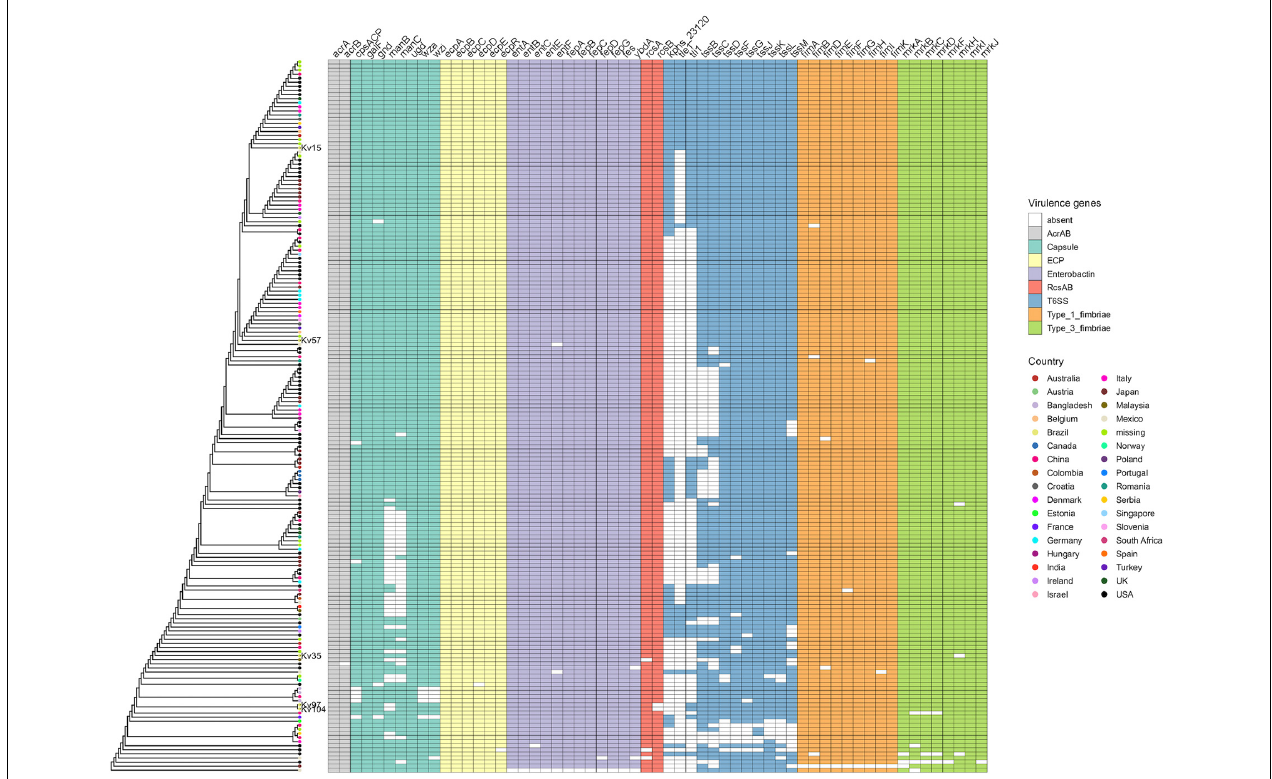
FIGURE 3 | Distribution of K. pneumoniae virulence factors among K. variicola genomes, represented in a presence/absence matrix of genes. The genomes have been clustered based on their gene